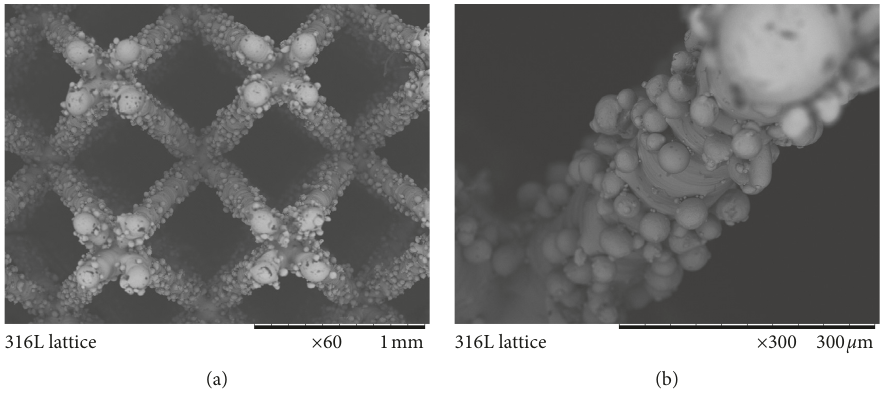
Figure 2: SEM micrographs of 3D printed 316L lattice.